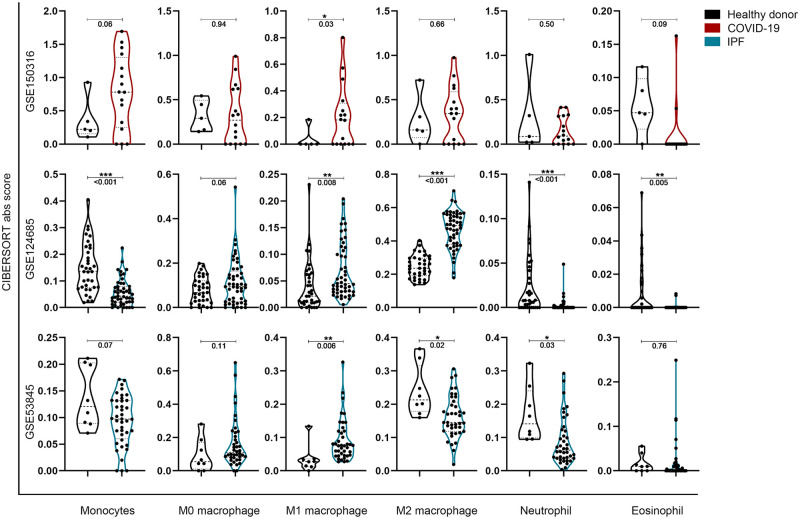
In silico simulated myeloblast lineage infiltration in lung tissue between COVID-19 and IPF patients.*P<0.05, **P<0.01 and ***P<0.001, with comparisons indicated by brackets.